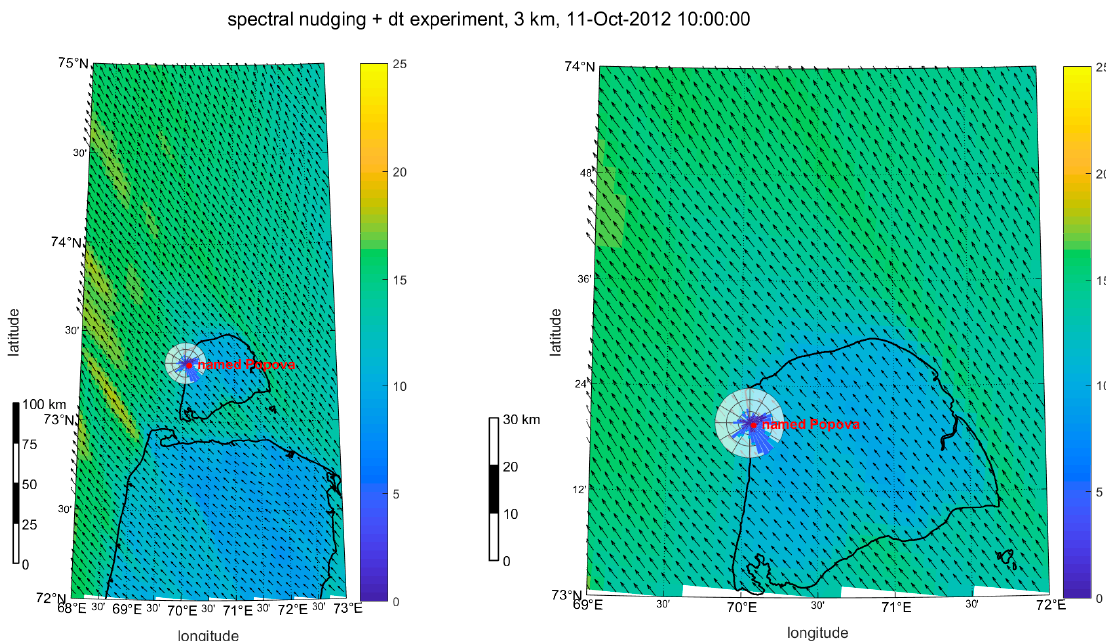
Figure 5. Wind speed (m/s) and direction at the named Popova (Belyi Island) station region on 10 October 2012, 900 GMT for the experiment ≈ 3 km grid, *_sn+dt. Right panel is the enlarged version of the left panel.